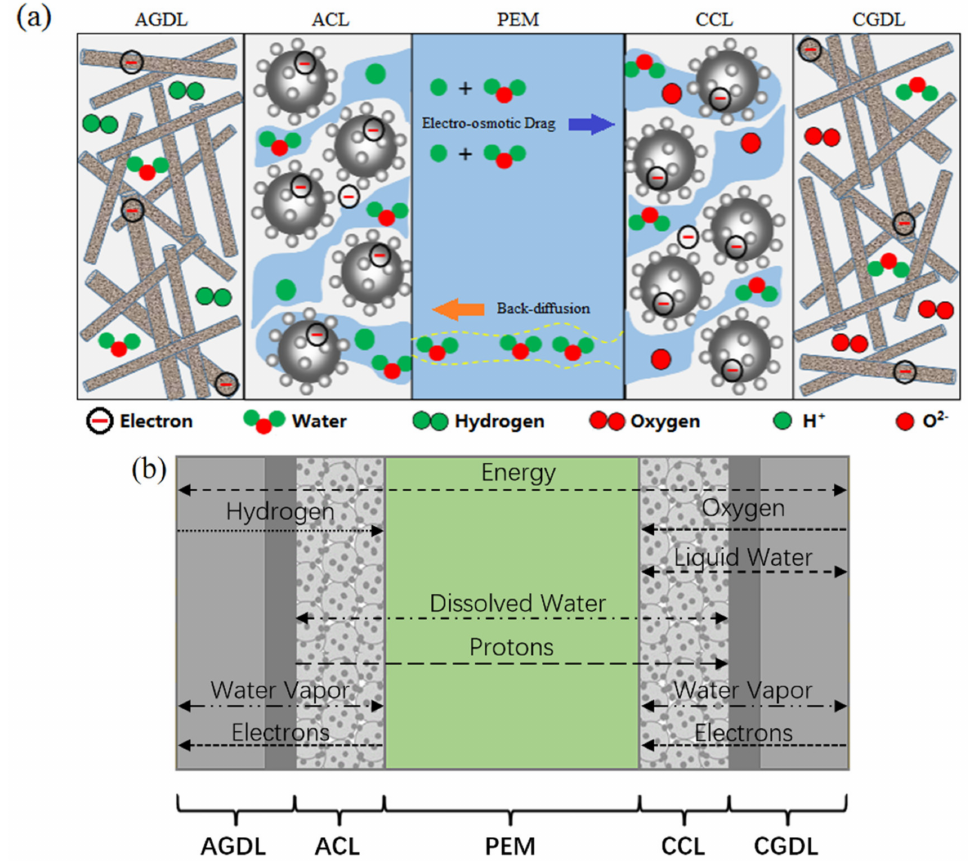
Figure 2. Schematic of ( a ) single cell and ( b ) computational